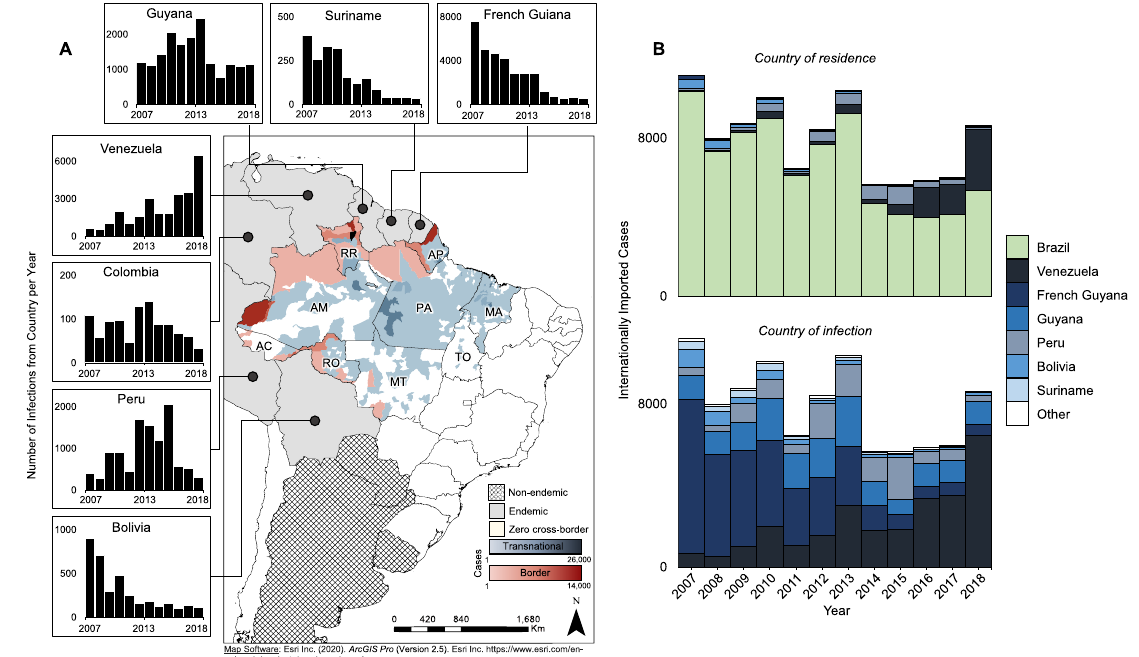
Figure 3. Descriptive plots of cross-border malaria burden in Brazil and case origins. ( A ) Map shows the intensity of transnational and border cases in Brazil between 2007 and 2018. State acronyms: AC = Acre, AP = Amapá, AM = Amazonas, PA = Pará, RO = Rondônia, RR = Roraima, TO = Tocantins, MA = Maranhão, MT = Mato Grosso. Bar charts demonstrate the number of cases annually entering Brazil from surrounding endemic countries. ( B ) Relative contribution of cases internationally imported into Brazil. Top bar chart details the country of residence; bottom bar chart details the country of infection. Maps created using ESRI ArcGIS